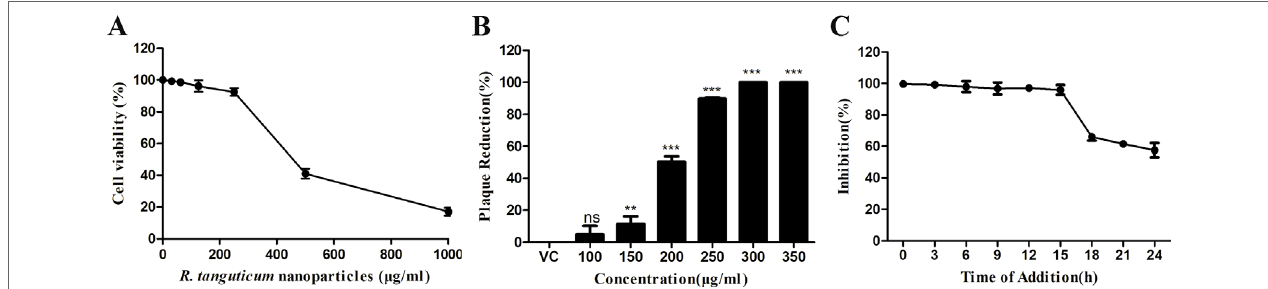
FIGURE 3 | R. tanguticum nanoparticles inhibition of HSV-1 replication. (A) HEp-2 cells in 96-well plates were treated with serial dilution of R. tanguticum nanoparticles for 72 h and the viability were measured by the MTT assay. (B) Inhibitory effects of R. tanguticum nanoparticles on HSV-1 infection. HEp-2 cells infected with HSV-1 were treated with different concentrations of R. tanguticum nanoparticles and were subjected to the plaque reduction assay. (C) Time-of- addition assay. HEp-2 cells were infected with HSV-1 and then treated with R. tanguticum nanoparticles (350 µg/ml) at indicated intervals. The progeny virus yields were determined by plaque assay. Values are represented as the mean ± standard deviation of three individual experiments. “VC” is the abbreviation of the “virus control group”.* p < 0.05; ** p < 0.01; *** p < 0.001; n.s., not